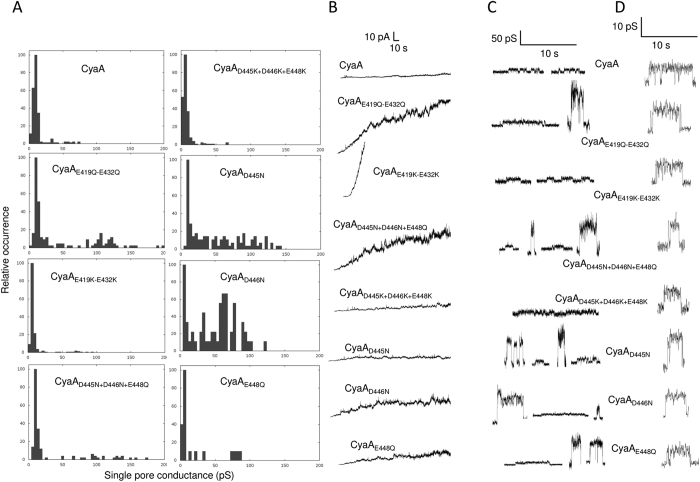
The conductance of single CyaA pores and membrane activity is affected by substitutions in blocks II and III.(A) Single-pore conductance of intact CyaA or its mutant variants (1 nM) was determined in 150 mM KCl, 10 mM Tris-HCl and 2 mM CaCl2 (pH 7.4) at 25 °C and membrane potential −50 mV. (B) Single-pore recordings of asolectin/n-decane membranes in the presence of 1 nM purified CyaA variants. The applied membrane potential was −50 mV and the temperature was 25 °C. (C) Representative recordings of the most frequent types of observed pores (the noise was suppressed by 50 Hz low-pass filter). (D) Detail of most frequent conductance states (filtered at 10 Hz). The presented events were acquired on several different asolectin membranes for each toxin. Measurement conditions: 150 mM KCl, 10 mM Tris, 2 mM CaCl2, pH 7.4, toxin concentration 0.1–1 nM, transmembrane potential −50 mV.